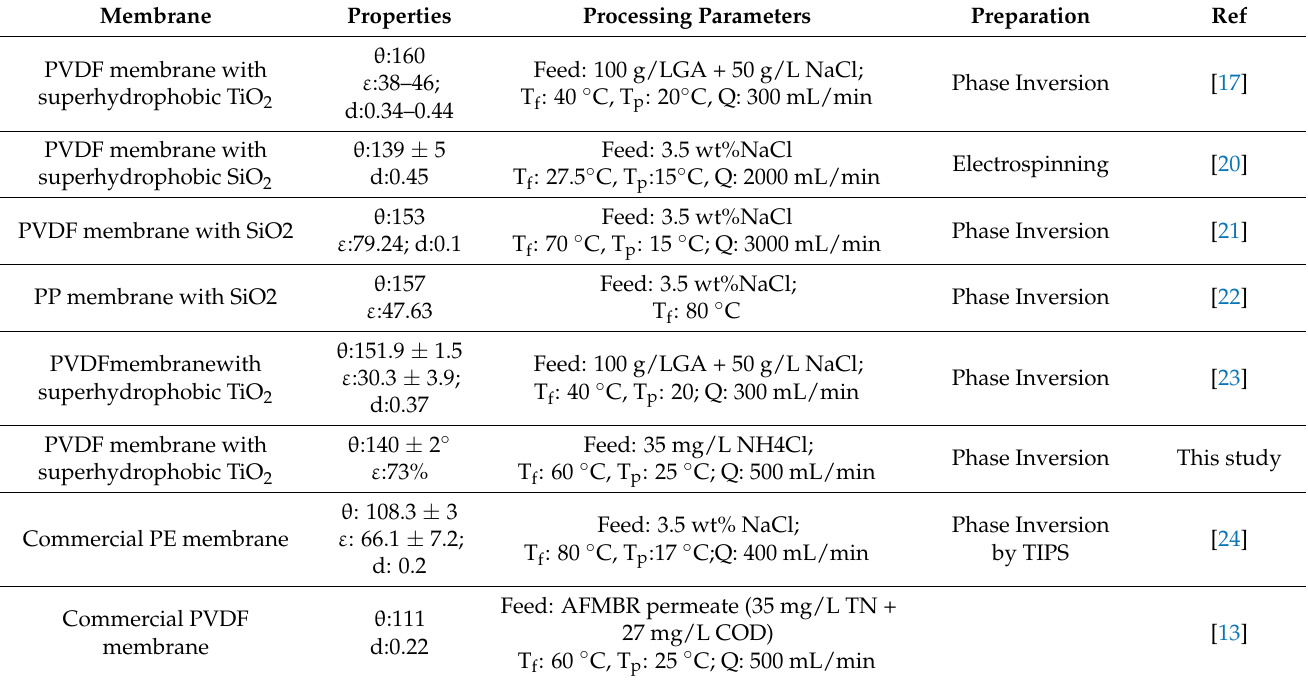
Table 1. Membrane properties and processing parameters for MD application in previous studies. Membrane Properties Processing Parameters Preparation Ref PVDF membrane with superhydrophobic TiO